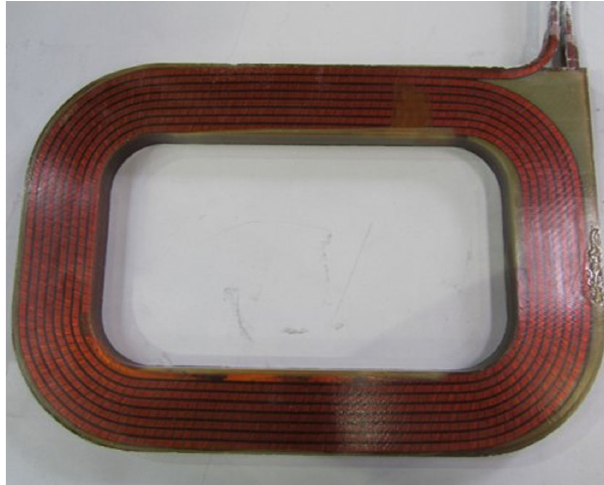
FIG. 14. Impregnated coil.